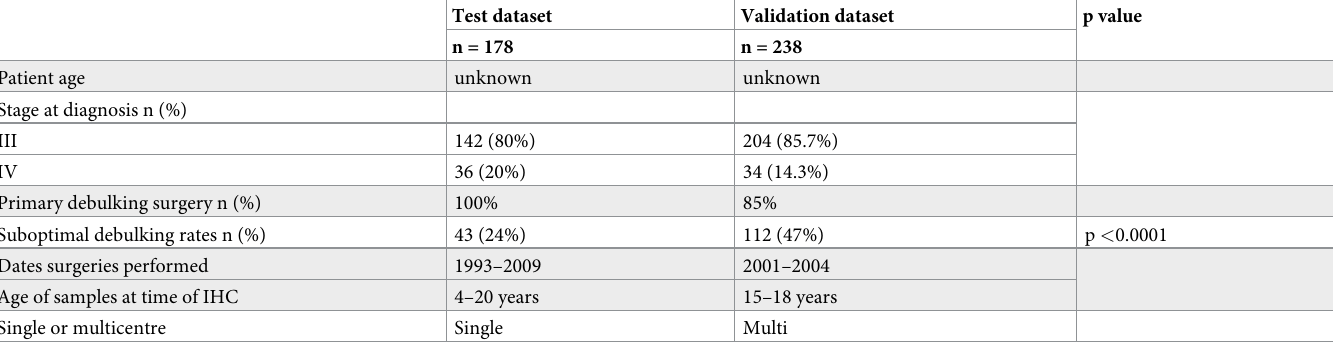
Table 1. Clinical characteristics of patients in original test set and current validation